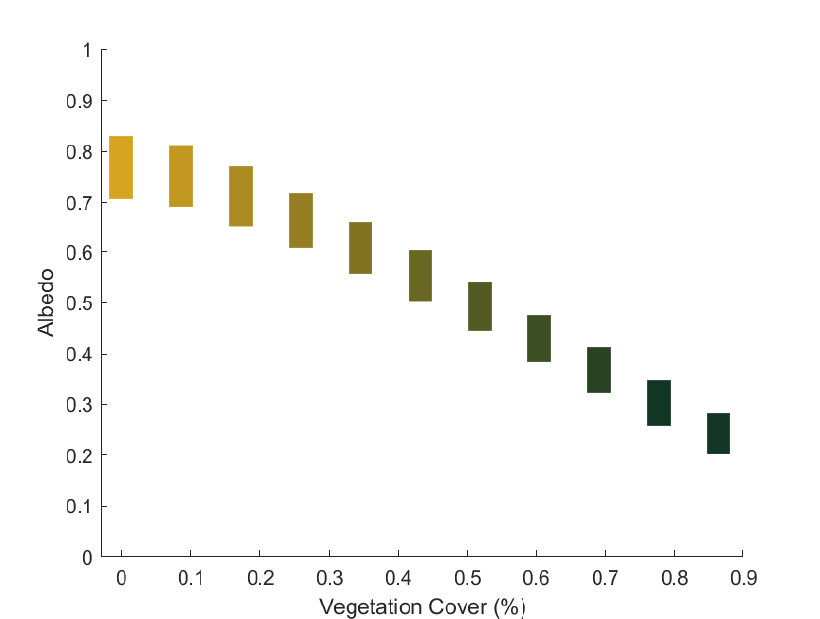
Figure 2. Total albedo as a function of vegetation percentage for each experiment. Bars denote the range of values for the